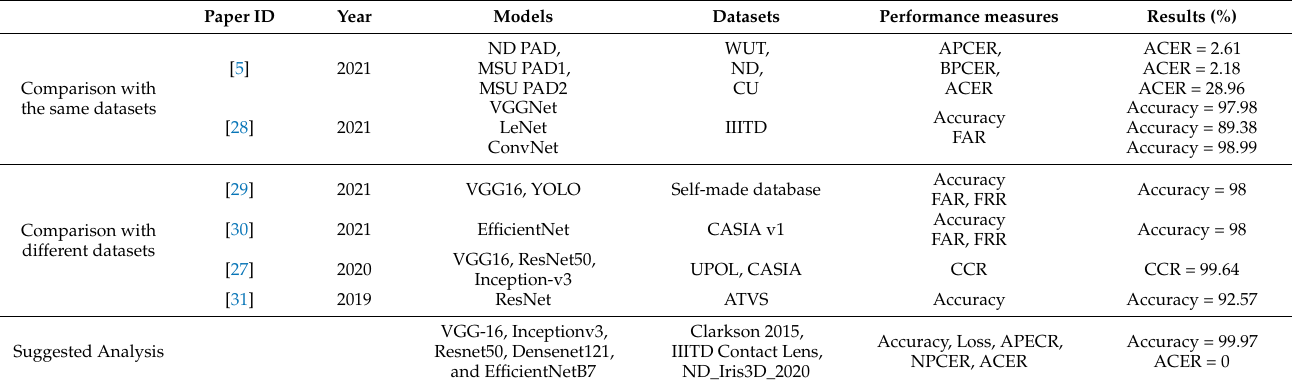
Table 11. Comparison with other related work that has performed iris liveness